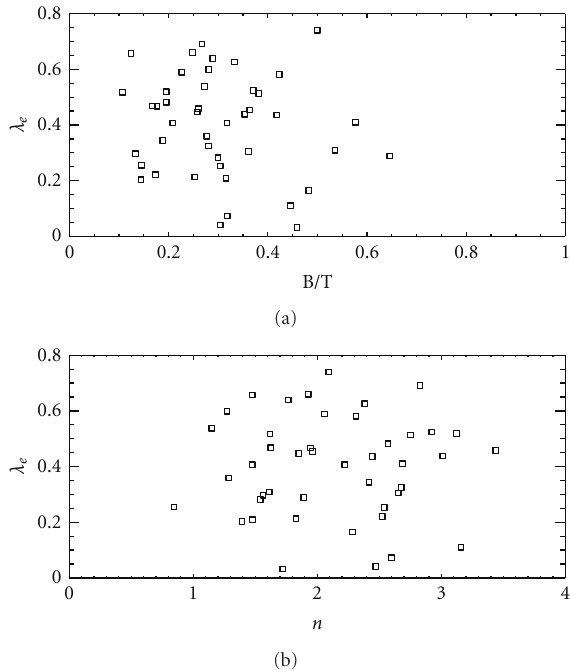
Figure 9: The kinematic parameter λ R versus B/T (a) and versus S´ersic n (b). Parameter λ Re , taken from Emsellem et al. [24], can be used as a discriminator between oblate and triaxial nature of the galaxies, within the apertures used in the measurements. In this plot λ R obtained within one e ff ective radius of the galaxy is used. The n parameters and the dust-corrected B/T values are taken from Laurikainen et al.